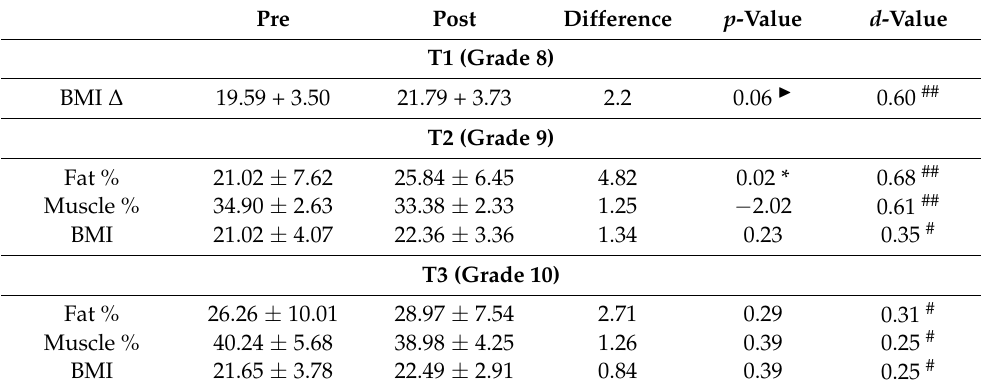
Table 2. Body composition differences between pre- and post-menarche groups during T2 and